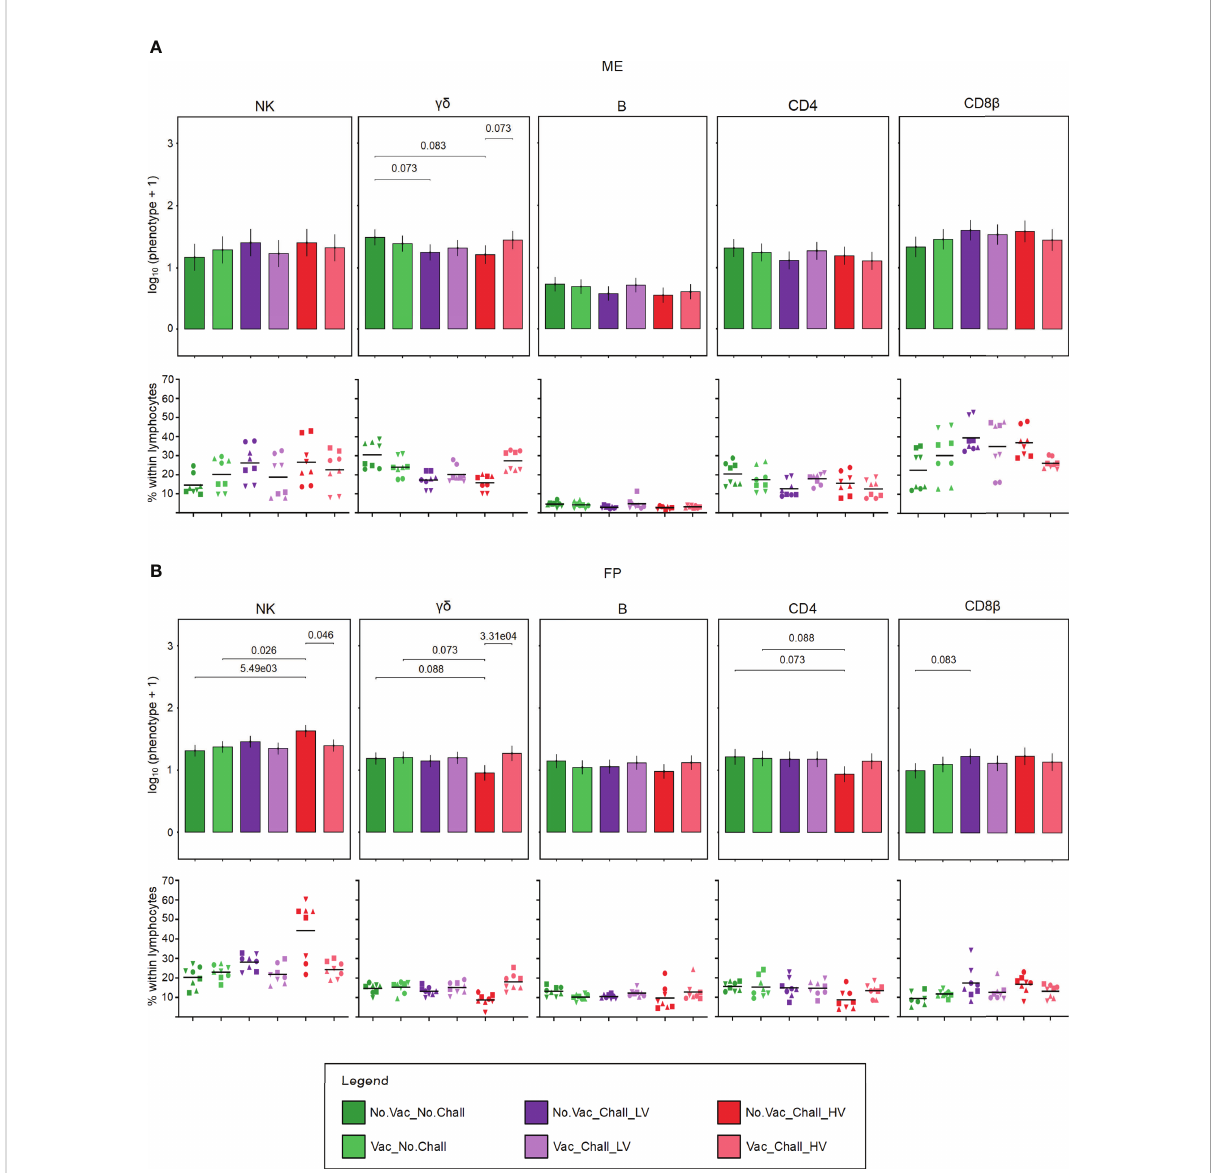
FIGURE 3 Major lymphocyte subsets at the maternal-fetal interface. Following the applied consecutive gating strategy (Supplementary Figure 1) NK cells, gd T cells, B cells, CD4 T cells, and CD8 b T cells were identi fi ed in the ME (A) and FP (B) . A linear mixed effects model considering the fi xed effects of treatment, tissue, and the interaction between both was applied. A random intercept (gilt) was fi tted and estimated marginal means (emmeans) were calculated. The bar plots (top panel; (A) ME; (B) FP) depict the results for the obtained major lymphocyte subsets across all treatment groups and are presented as emmeans of each subset on a log 10 + 1 scale as depicted on the y-axes. Only signi fi cant p-values (p < 0.1), corrected for multiple testing using a false discovery rate approach, across all 234 pairwise comparisons of contrasts, are shown above the brackets. The whiskers depict the 95% con fi dence intervals of the emmeans. Frequencies of the major lymphocyte subsets, within viable lymphocytes corrected for CD45 expression, are given (bottom panel; (A) ME; (B) FP). For all graphs, results for each individual fetus are shown and different symbols indicate fetuses from different gilts. The black bars in the graphs display the mean within the respective treatment group within the speci fi ed anatomic location. For all bar plots and graphs shown, the depicted treatment groups are: No.Vac_No.Chall (dark green, non-vaccinated and non-infected), Vac_No.Chall (light green, vaccinated and non-infected), No.Vac_Chall_LV (dark purple, non-vaccinated and infected low virulent strain), Vac_Chall_LV (light purple, vaccinated and infected low virulent strain), No.Vac_Chall_HV (dark red, non-vaccinated and infected high virulent strain), and Vac_Chall_HV (light red, vaccinated and infected high virulent